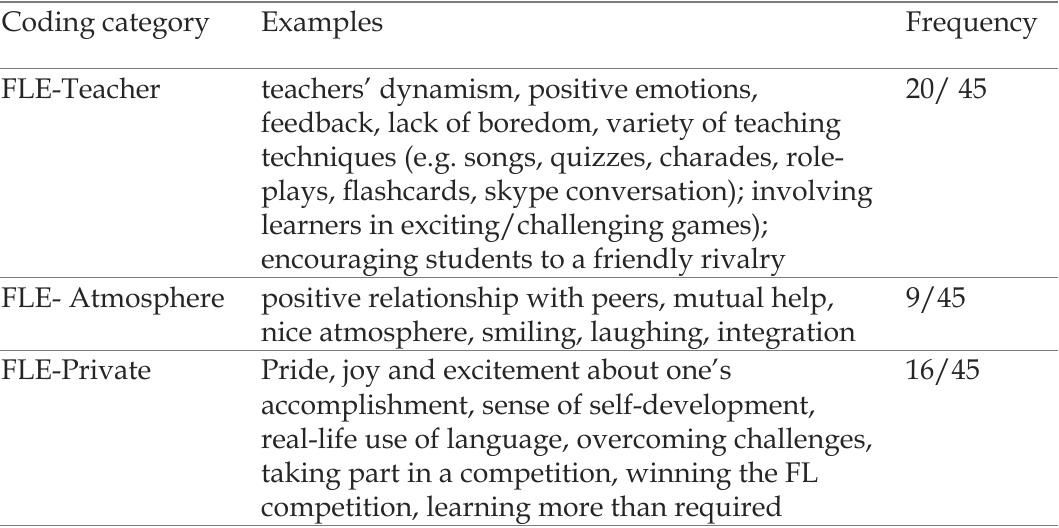
Learners’ sources of FLE according to teachers, examples and frequency of mentions by the participants